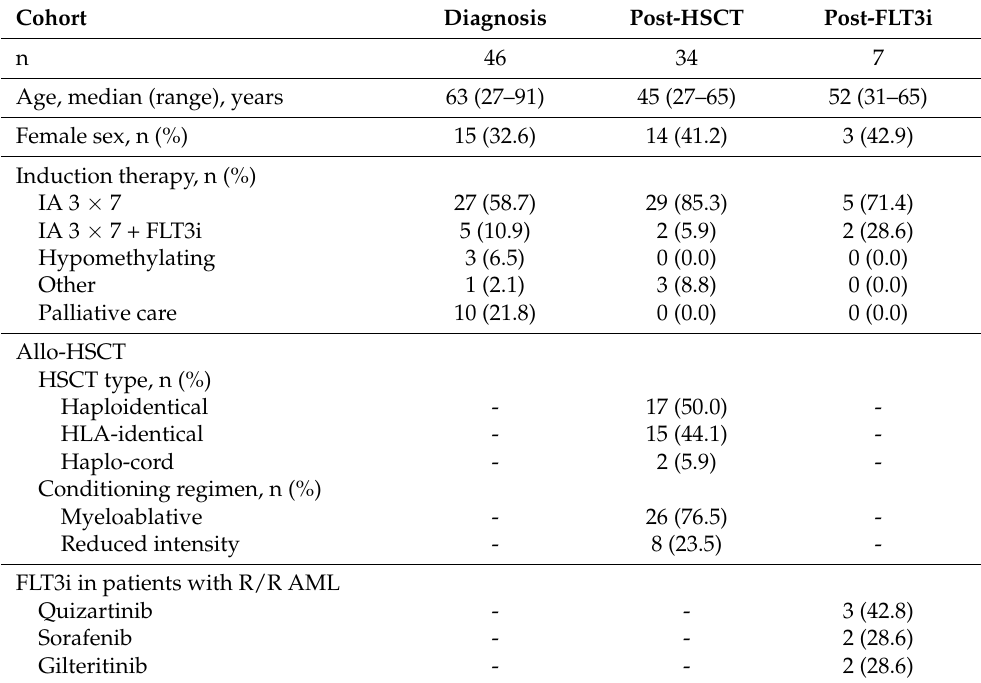
Figure 1. Venn diagram showing the distribution of patients within the cohorts of the study. Allo- HSCT: allogeneic hematopoietic stem cell transplantation. FLT3i: tyrosine kinase inhibitor. Table 1. Demographic and clinical characteristics of patients of the three cohorts. Allo-HSCT: allogeneic hematopoietic stem cell transplantation. FLT3i: tyrosine kinase inhibitor. IA: idarubicine and cytarabine. R/R AML: refractory/relapsed acute myeloid leukemia.